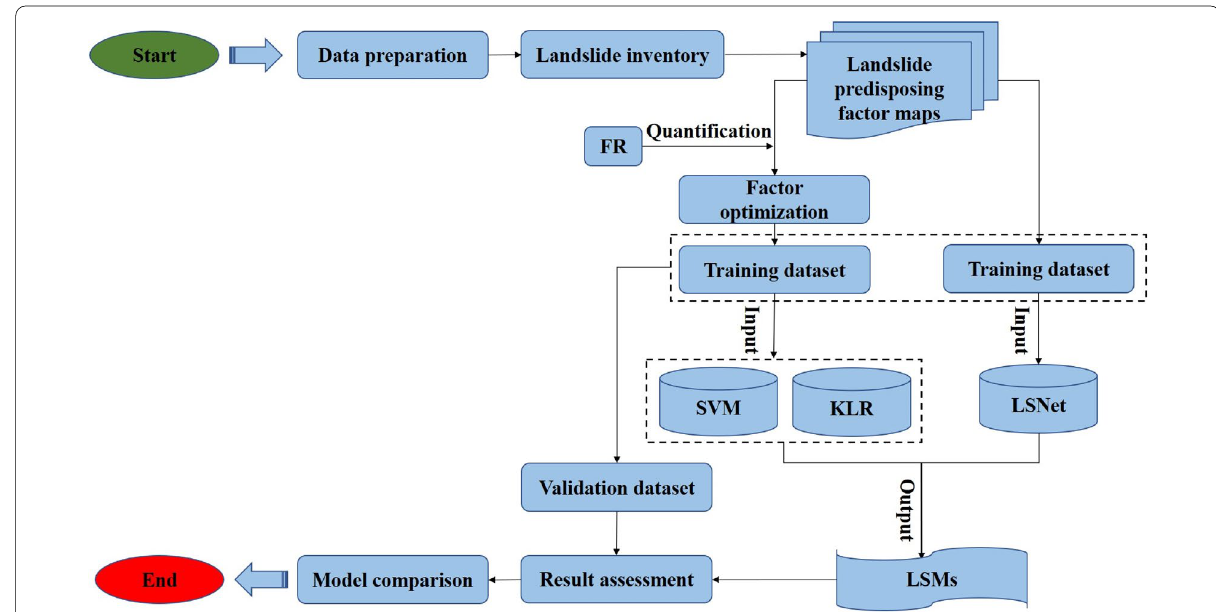
Fig. 3 The flowchart of the